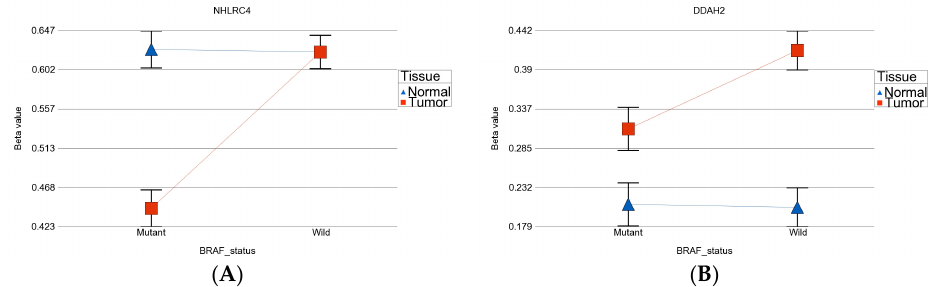
Figure 1. Examples of interaction between methylation status and mutation status. The left figure ( A ) shows larger magnitude of differential methylation (hypomethylation) in BRAF mutant tumor. The right figure ( B ) shows larger magnitude of differential methylation (hypermethylation) in BRAF wild type tumor.